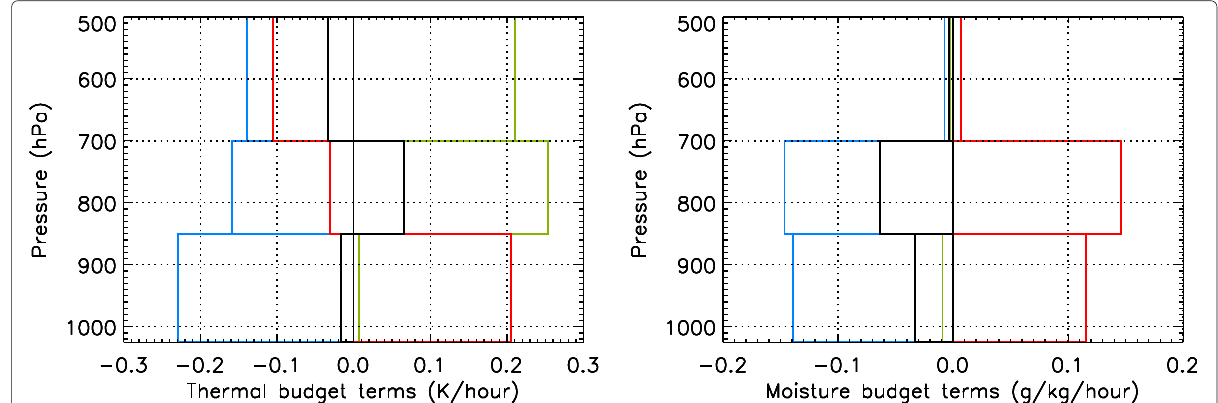
Fig. 5 Vertical profiles of the temperature and moisture budget. (Left) Local temperature change ∂ T /∂ t (black), horizontal temperature advection − v · ∇ T (light blue), vertical temperature advection − ω same as the left panel, except for the moisture budget: local moisture change ∂ q /∂ t (black), horizontal moisture advection − v · ∇ q (light blue), vertical moisture advection − ω (∂ q /∂ p ) (green), and individual change in moisture δ q /δ t